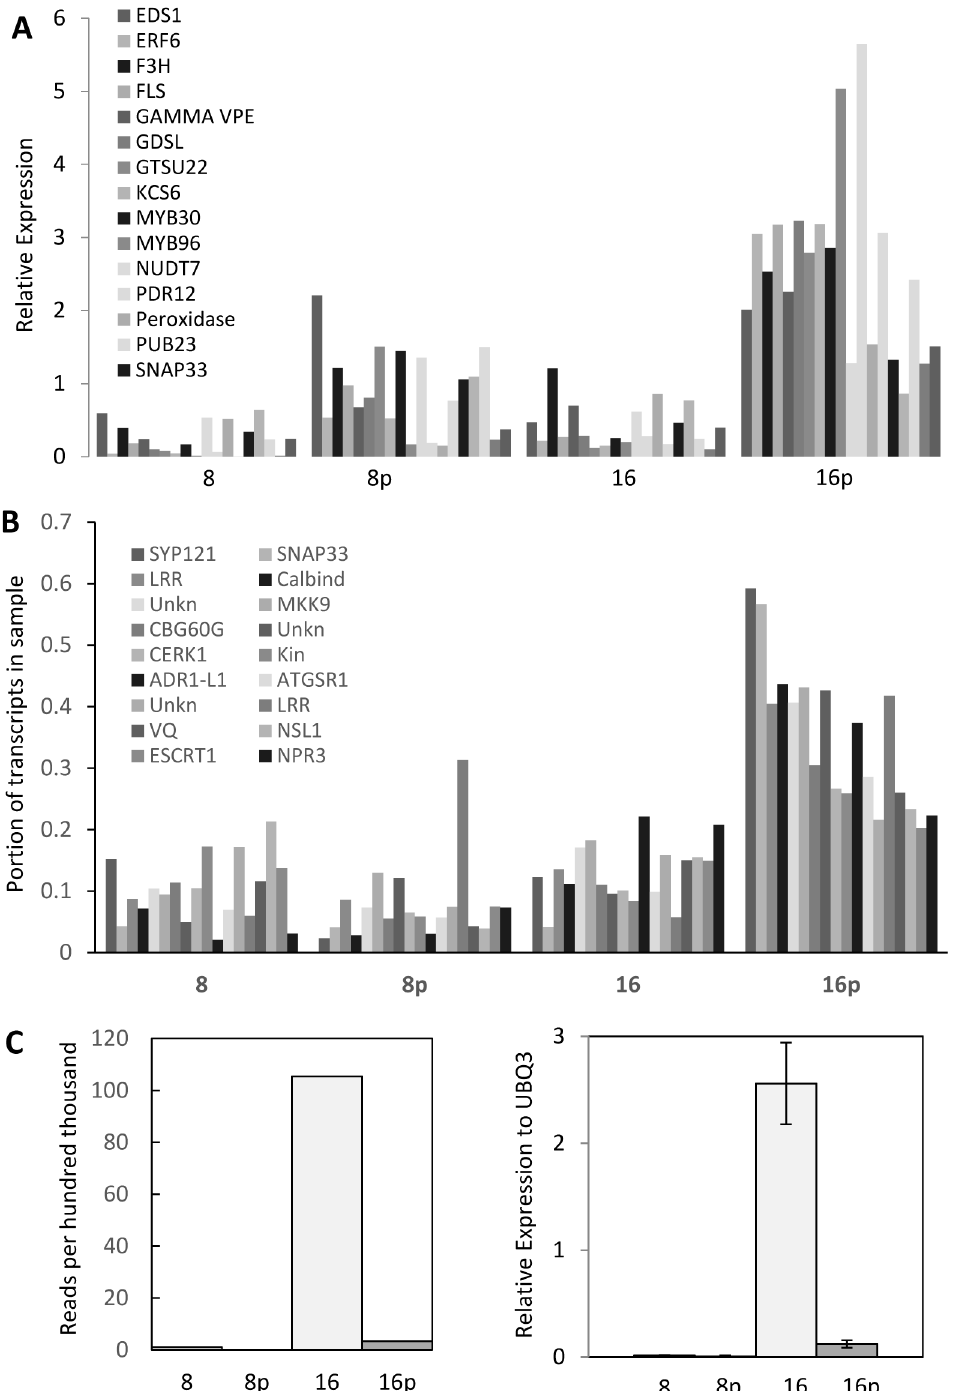
Fig 4. Expression analysis of putative defense related genes. (A) qRT-PCR verification of potential pathogen defense-related genes with elevated expression in 16 days post pollination (dpp) peels. (B) Relative expression of SYP121/SNAP33 co-expressed genes in 8 and 16 dpp pericarp and peel samples as assessed by 454 pyrosequencing. Genes shown are in the order listed in Table 4. (C) Expression of CsFM01 as assessed by 454 pyrosequencing (left) and qRT-PCR analysis (right). 8 = 8 dpp pericarp; 8p = 8 dpp peel; 16 = 16 dpp pericarp; 16p = 16 dpp peel.